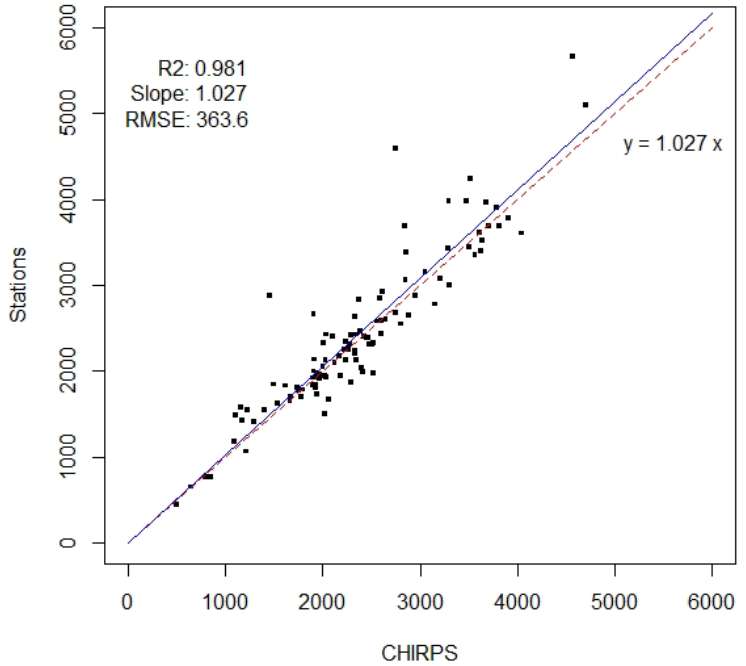
Figure 3. Absolute annual mean values from CHIRPS and the in-situ P stations with more than 20 years of data (black points), with one-to-one (blue) and regression (red) lines.